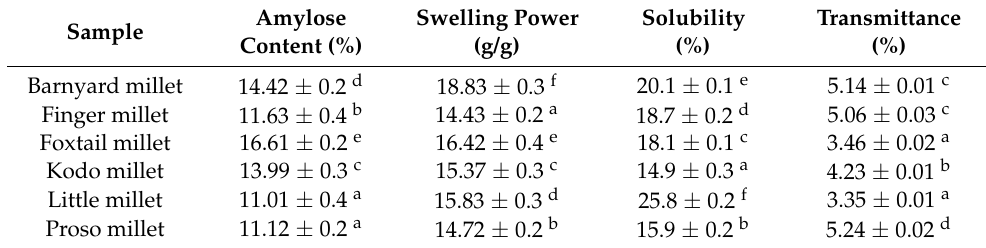
Table 1. Physicochemical properties of millet starches.